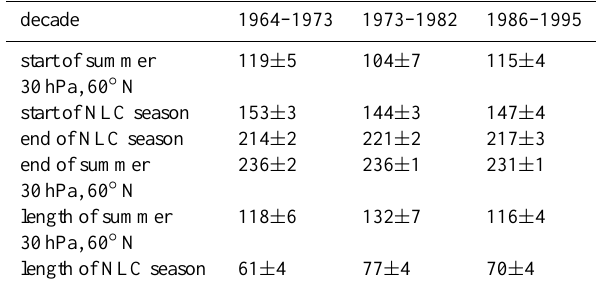
Table 1. Average dates (day number) for the start and end of the summer season in the stratosphere (30hPa, 60 ◦ N), and the NLC season, for the decades shown. Summer in the stratosphere is de- fined as the period during which the zonal mean zonal wind is directed towards the west. This has been determined using the ERA40 reanalysis 1964–2002 and operational analyses thereafter (all from European Center for Medium Range Weather Forecast- ing, ECMWF). Start and end of the NLC season are for all reliable NLC reports, including faint and very faint NLC. Note that the con- fidence limits given here are the standard errors of the means, not the standard deviation of the